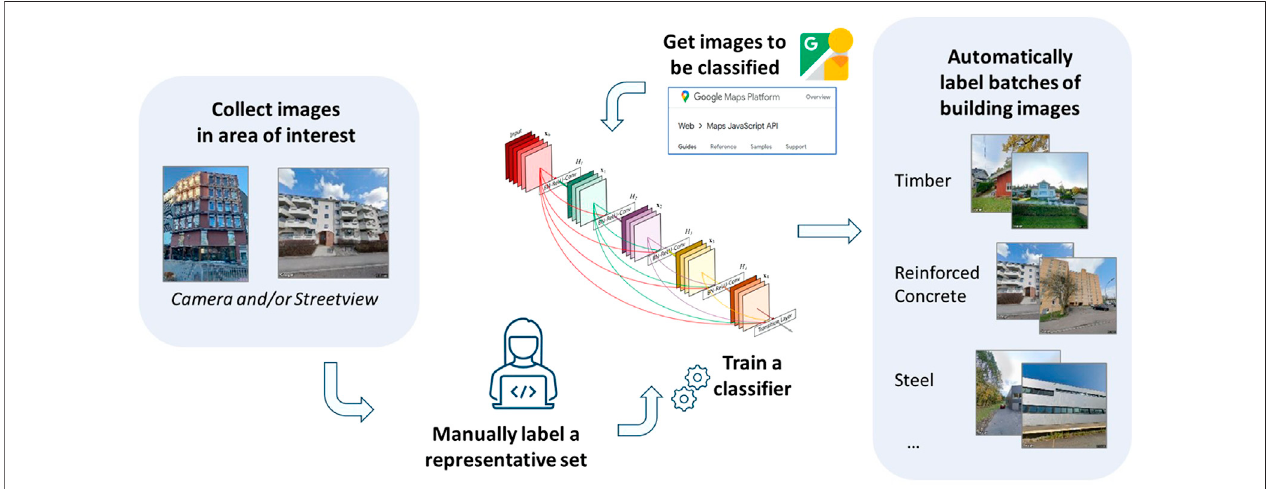
FIGURE 1 | Work fl ow diagram. Using manually annotated façade images from fi eldwork, from GSV, or a combination of the two, a CNN is trained to classify building typologies. A large set of images is then downloaded from GSV, and automatically classi fi ed to obtain the building stock for the area of interest.